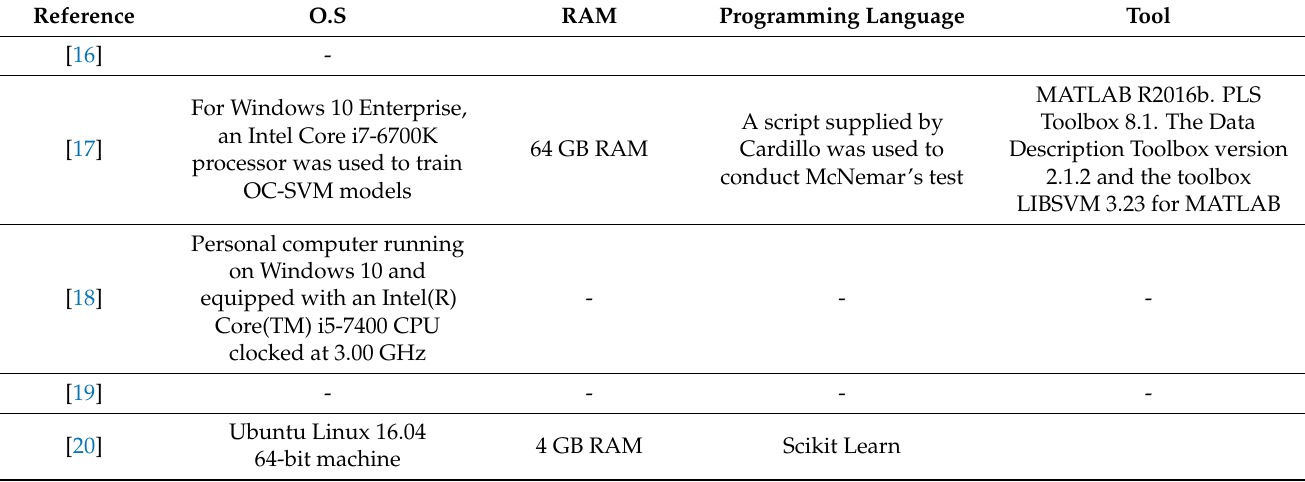
Table 3. The Experimental Setup for Related